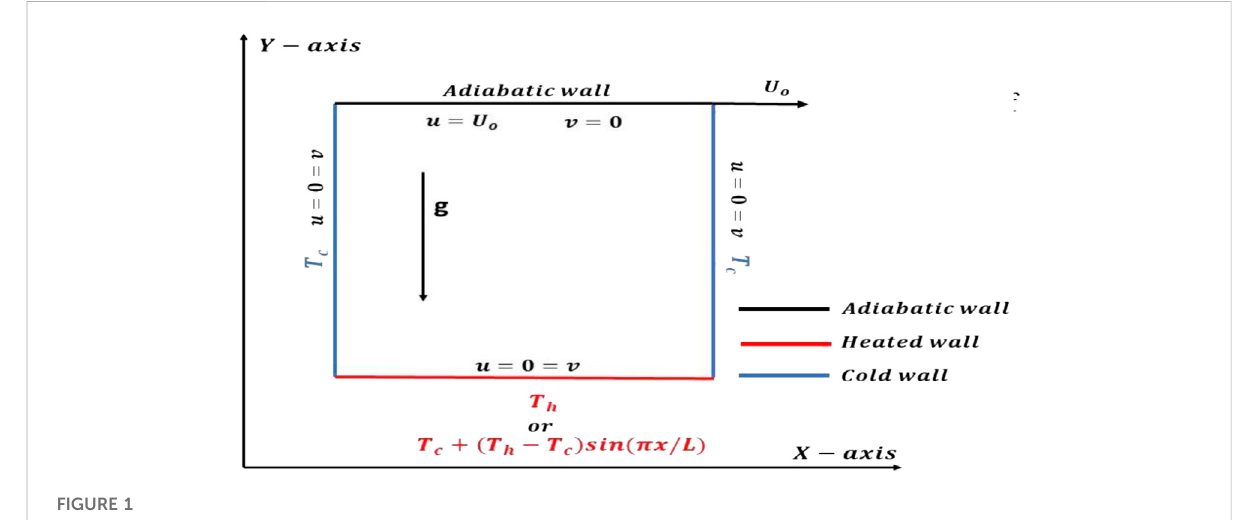
FIGURE 1 Visualization of the enclosure with boundary constraints.